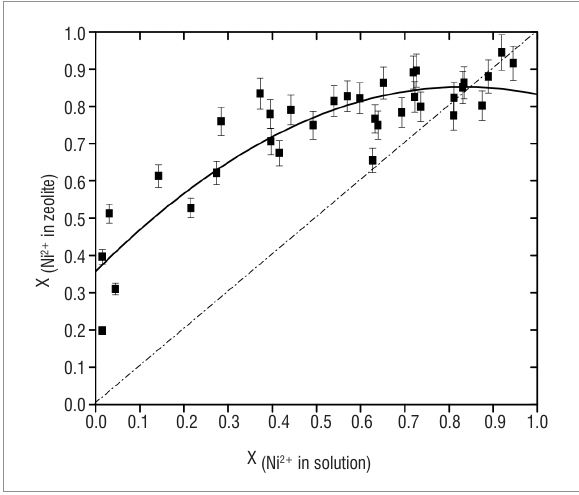
Figure 1: The Na + -Ni 2+ isotherm at 298.15 K. X (Ni2+ in soln) : equivalent fraction of ingoing nickel in the liquid phase. X (Ni2+ in Zeo) : equivalent fraction of ingoing cation in the solid phase. Percentage error bars for all points are indicated. The solid curve is a polynomial fit of order 2.